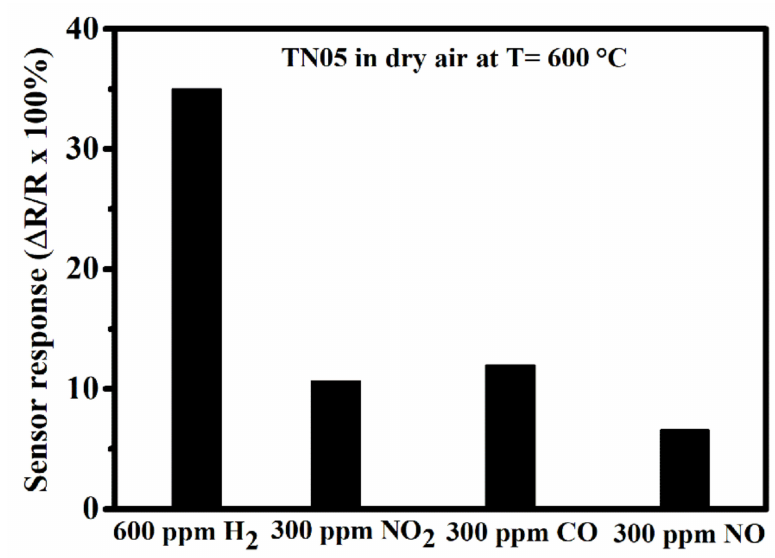
Figure 10. Response of gas sensor based on 0.5% Ni-doped TiO 2 to various gases including 600 ppm of H 2 , 300 ppm of NO 2 , NO and CO all in dry air at 600 ◦ C.